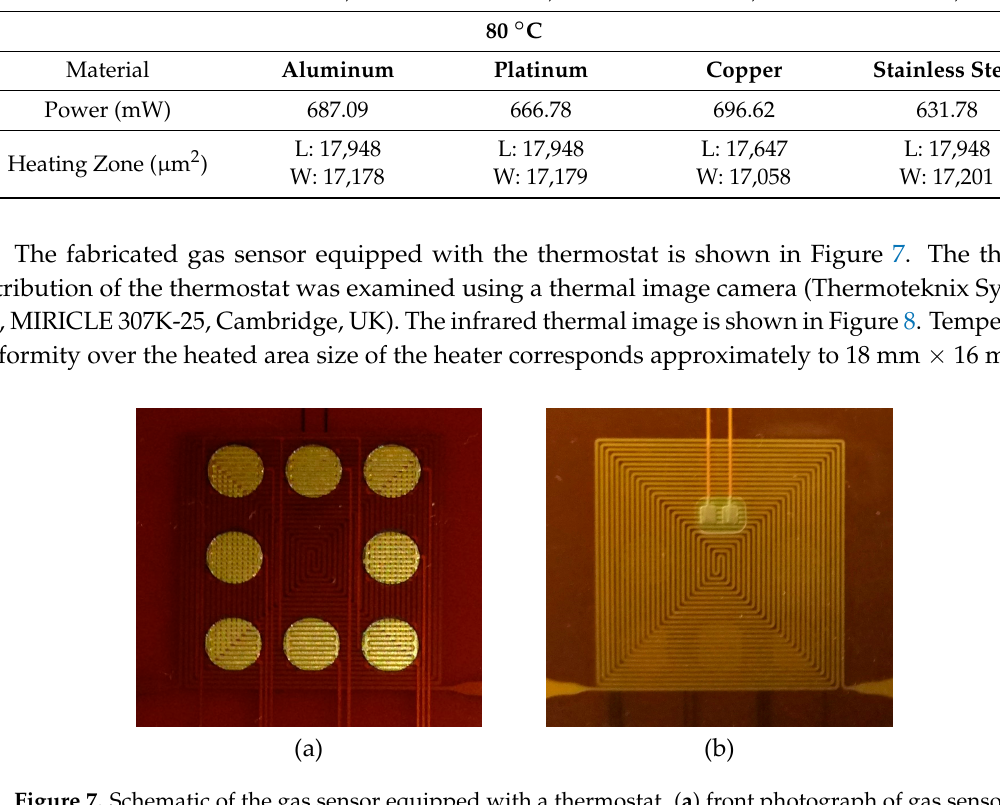
Figure 8. Infrared thermal image of thermal distribution. 4.2. Characterizations The top-view images of PEG/MWCNTs composite film and cross-sectional morphology of gas sensor were observed by a NOVA NANO SEM 450 (FEI Co., Hillsboro, OR, USA) with 10 kV acceleration voltage. The scanning electron microscope (SEM) morphologies are shown in Figure 9. The thickness of the PEG/MWCNTs composite sensing film fabricated by drop-casting method was about 217.6 nm, and MWCNTs were well wrapped in PEG film.